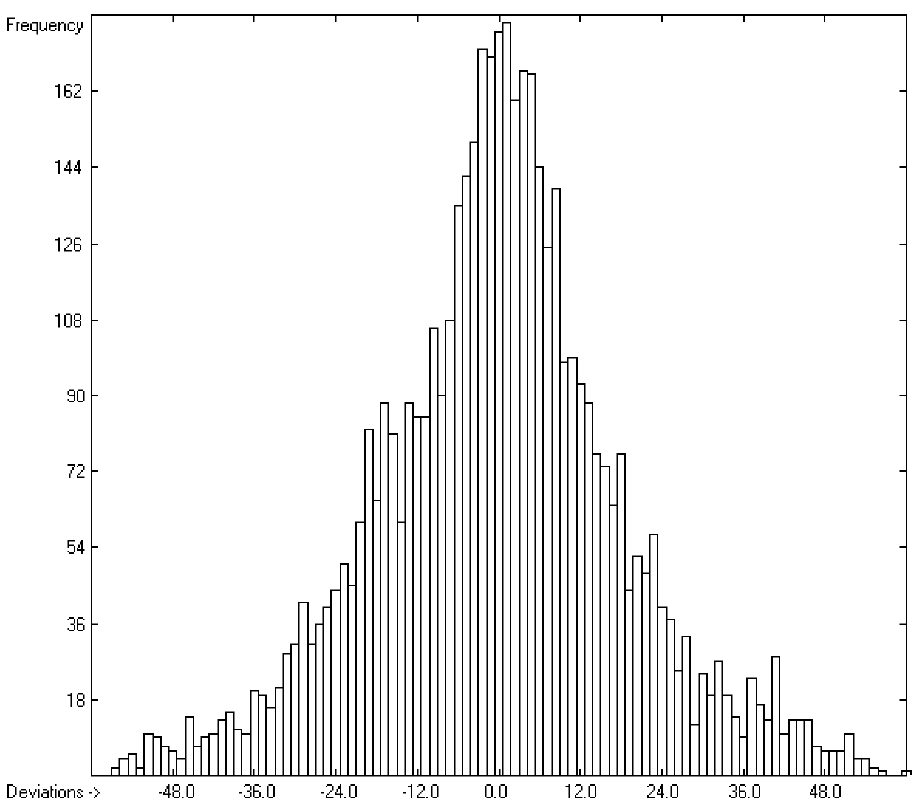
Figure 4. Histogram of the heat of formation (in kJ/mol) ( σ = 18.14; experimental values range from − 7238.2 to +1039.7 kJ/mol).